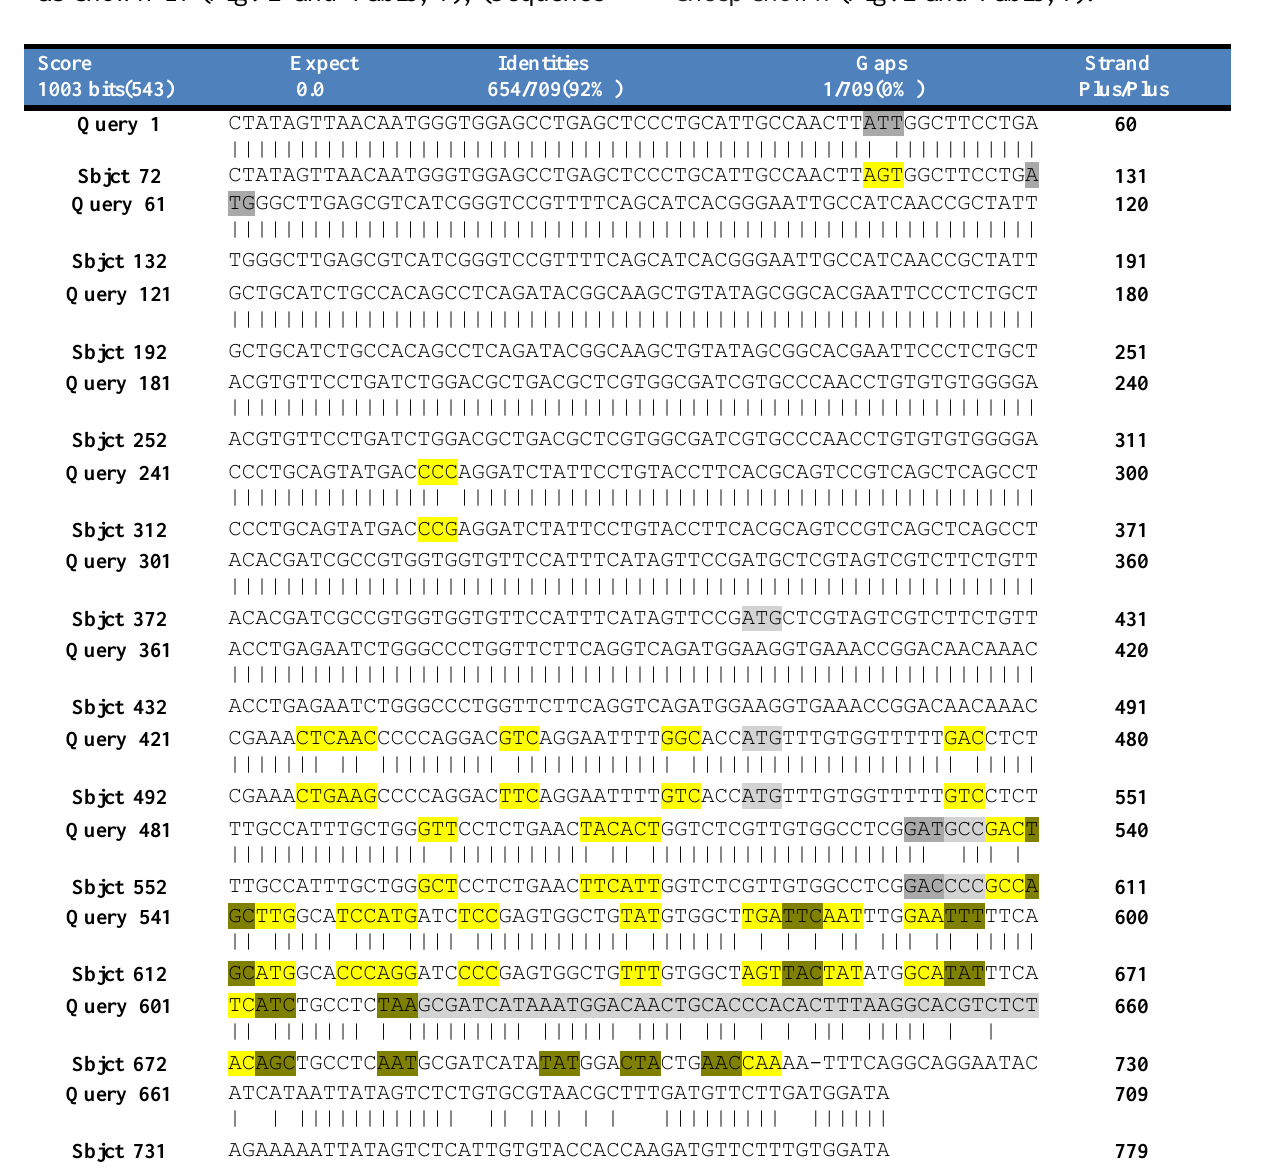
Figure, 2: Sample Ovisaries isolate K45 melatonin receptor type 1A (MTNR1A) gene, MTNR1A-R allele, exon 2 and partial